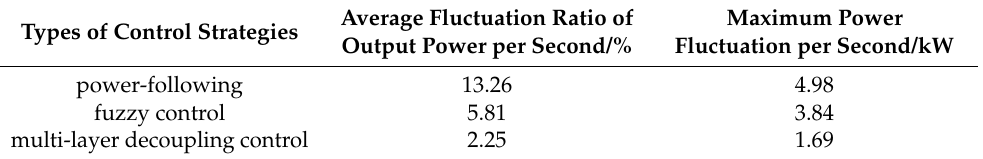
Table 3. Comparison of the fluctuation of the PEMFC of different control strategies.